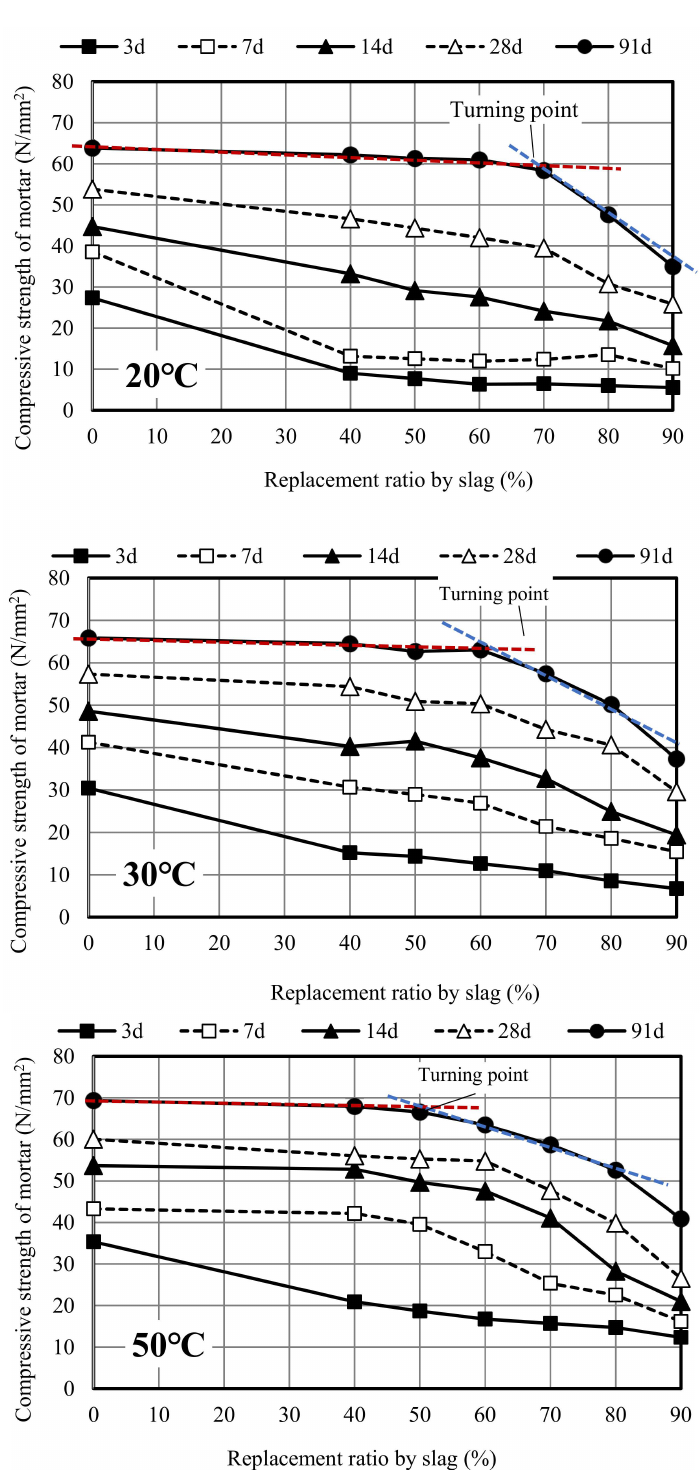
Figure 3. Compressive strengths of slag mortar at di ff erent curing